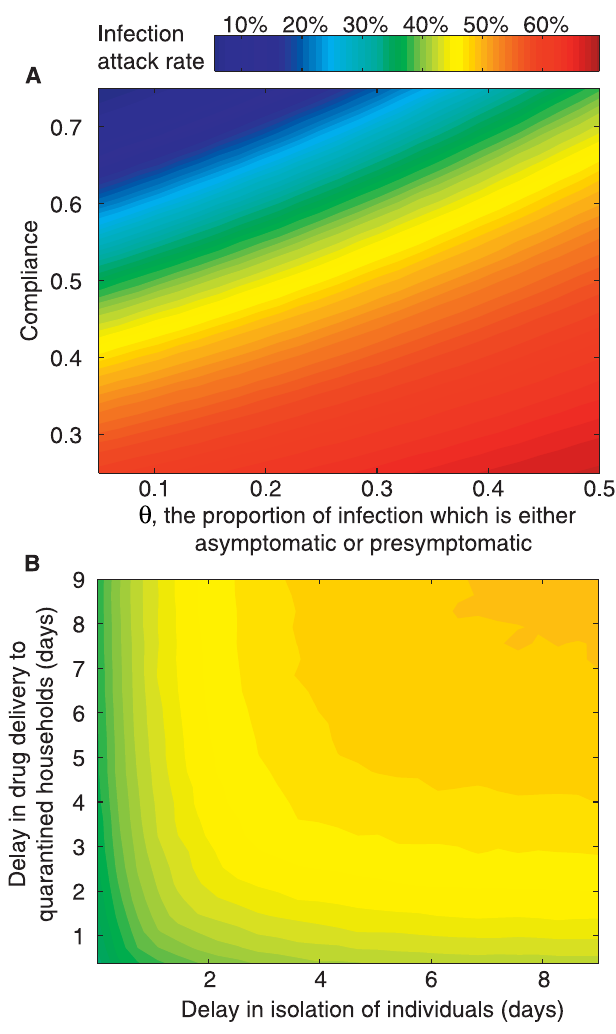
Figure 4. Bivariate Sensitivity Analyses (A) The sensitivity of our estimates of the efficacy of Q to changes in the compliance rate and to changes in h , the proportion of infections that are either asymptomatic or presymptomatic. (B) The sensitivity of our estimates of the efficacy of QIA to changes in the delay in the delivery of drugs to quarantined households and to changes in the delay in the isolation of individuals. All other parameters are held constant at their baseline values (see Figure 1 and Table